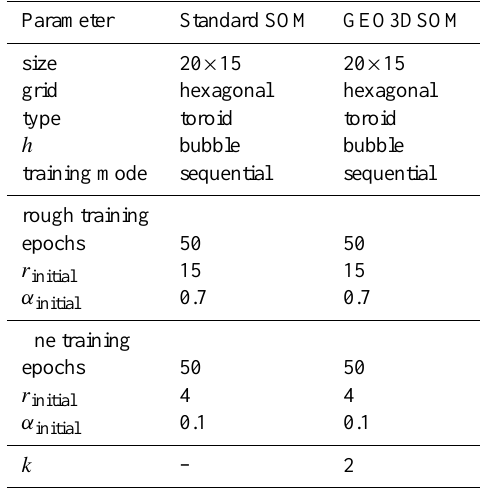
Table 2. Parameters of SOM and GEO3DSOM-analysis.